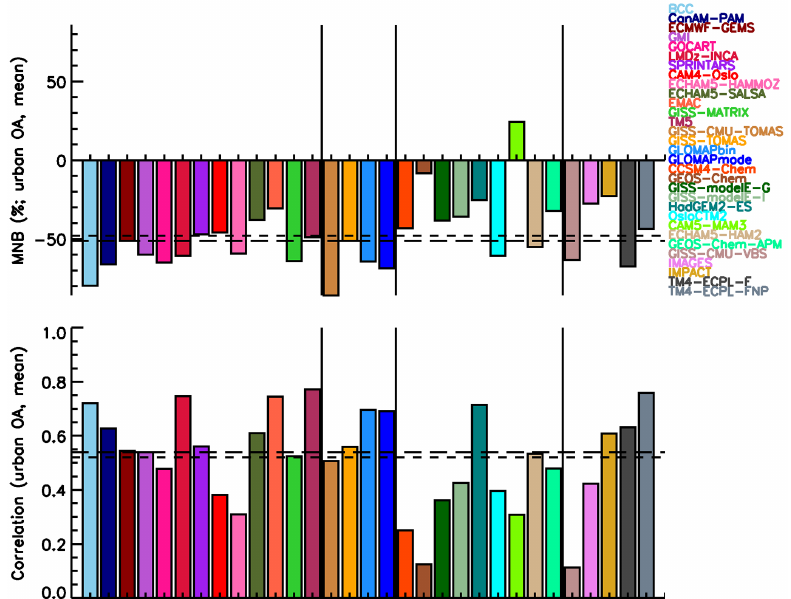
Figure 11. Same as Fig. 10, for urban OA